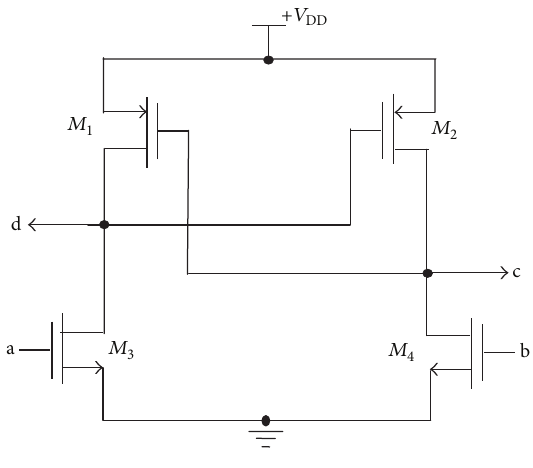
Figure 4: Conventional DCVSL structure.